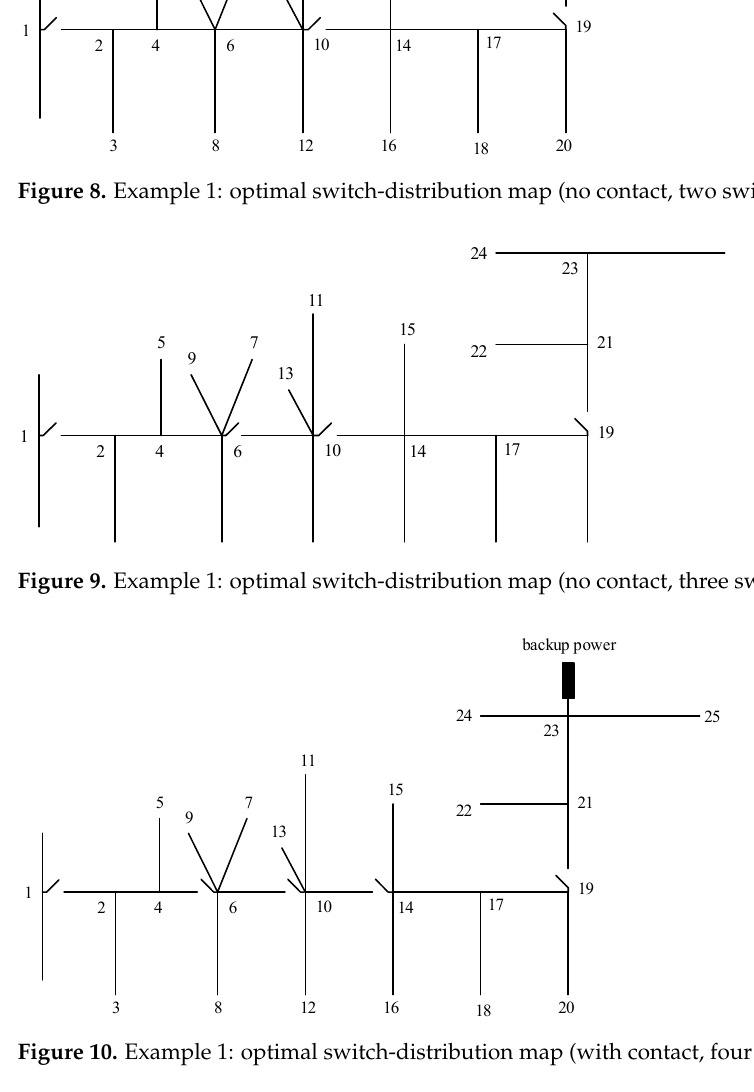
Figure 11. Example 1: optimal switch-distribution map (with contact, five switches). Table 2 lists the comparison between the calculation optimisation results of the method used in the present study and that in [28,29]. Through the calculation, when the line is not connected, we install three switches to optimise the section, i.e., we divide the line into four sections. When four switches are installed, the optimal positions are at the power terminals of 6–10, 10–14, 17–19, and 21–23. The ENS is 3.513 MW·h/year, which is 3% lower than that in the three-switch ENS and satisfy constraint condition number (4). The optimal three switches are located at the power terminals of 6–10, 10–14, and 19–21, and the ENS is 3.593 MW·h/year. The method in [29] also installs three switches, but the positions of the switches are arranged at the power terminals of 4–6, 10–14, and 19–21; the ENS is 3.684 MW·h/year. The method used in the present study is the same as that in [29], i.e., the same number of switches. Thus, investment is the same, which can reduce ENS by 2.47%, and the system reliability is higher. Reference [28] chose to install only two switches for cost considerations, which were arranged at the 6–10 and 14–17 power termi- nals, and the ENS was 3.900 MW·h/year. However, the position was not optimal. The op- timal position of the two switches determined by the method used in the present study is at the 10–14 and 19–21 power terminals, and the ENS is 3.851 MW·h/year. Compared with